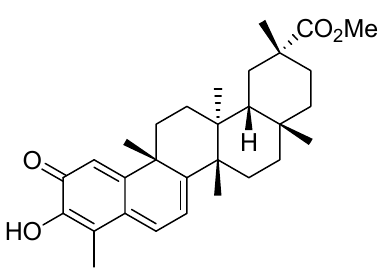
Figure 1. Chemical structure of